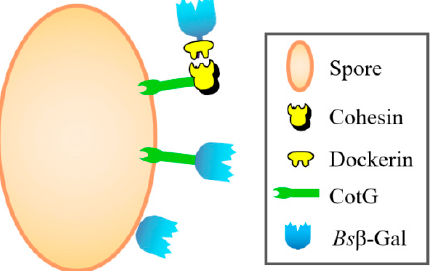
Figure 1. Scheme of three different types of Bs β –Gal B. subtilis spore display formats.